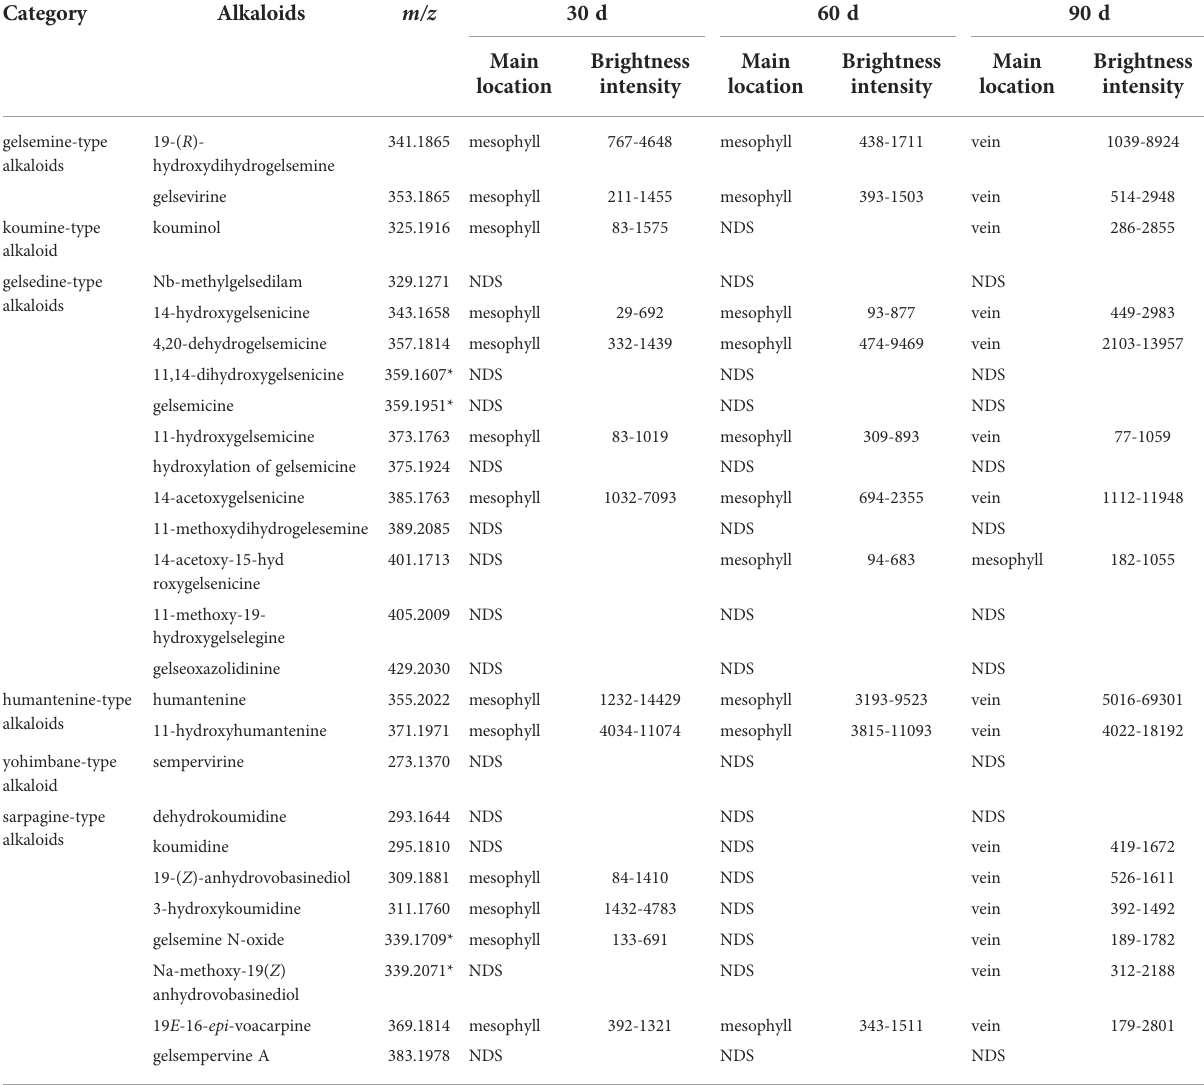
TABLE 4 Distribution of alkaloids in seedling leaves.